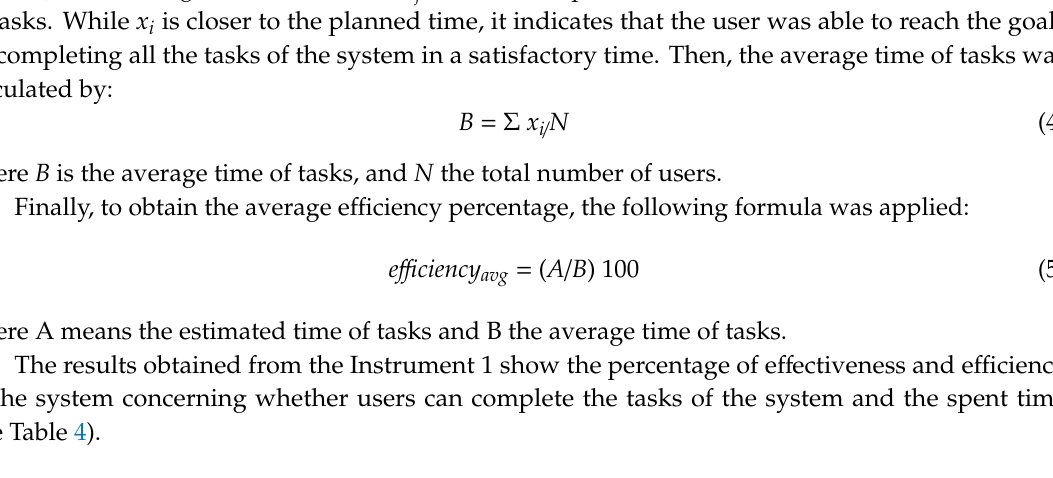
Table 4. Results of e ffi cacy and e ffi ciency based on the analysis of the Instrument